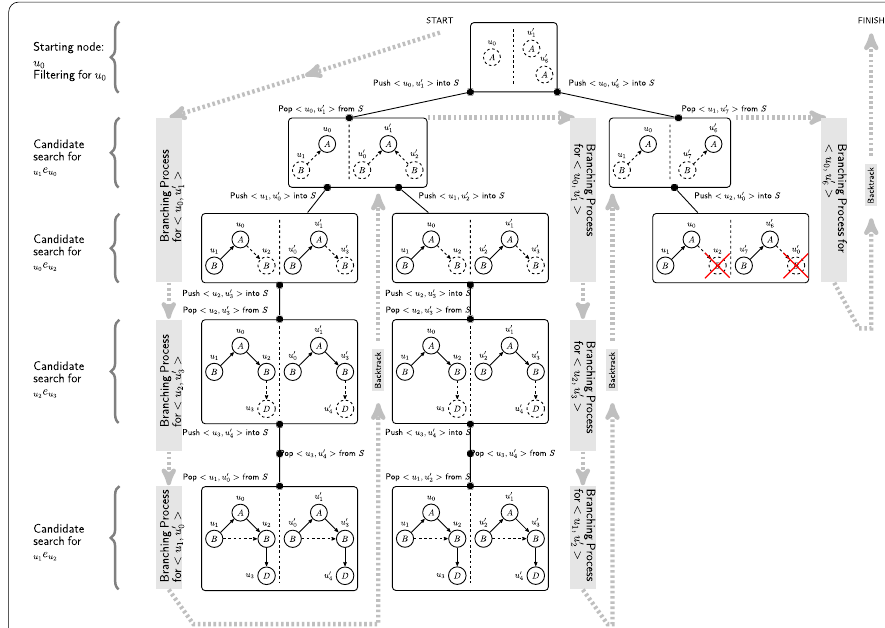
Fig. 4 A sample execution for the query graph and graph database given in Fig. 1. Each level of the diagram represents the candidate relationship search for edge matching. At the rectangle boxes of each level the found candidates are shown in dashed lines whereas the already matched nodes and relationships are shown in non-dashed lines. At each rectangle box, operations in query part and database part of the reciprocal node branching process are shown in left and right parts of the box, respectively. The execution flows in the arrow